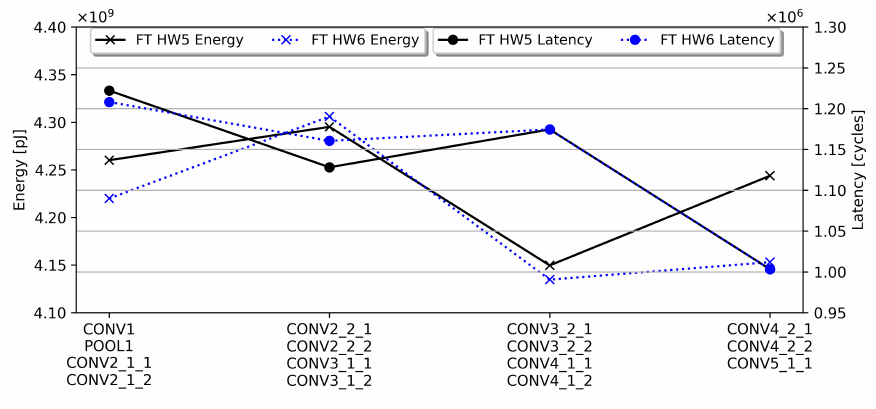
Figure 16. Energy and latency for ResNet18, mapped with temporal fusion with HW config. 5 and